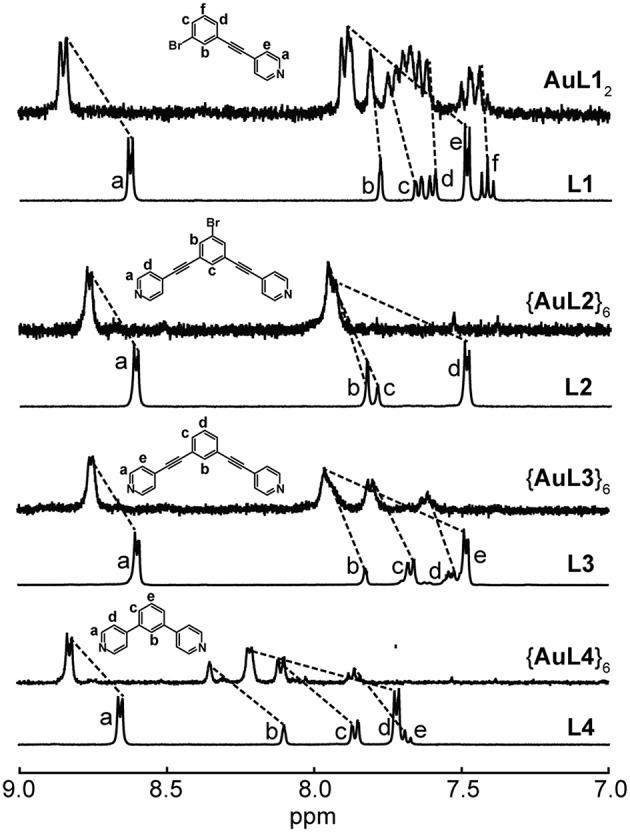
1H NMR spectra of L1 and AuL12 in acetone-d6, L2 and {AuL2}6, L3 and {AuL3}6 and L4 and {AuL4}6 in nitromethane-d3.